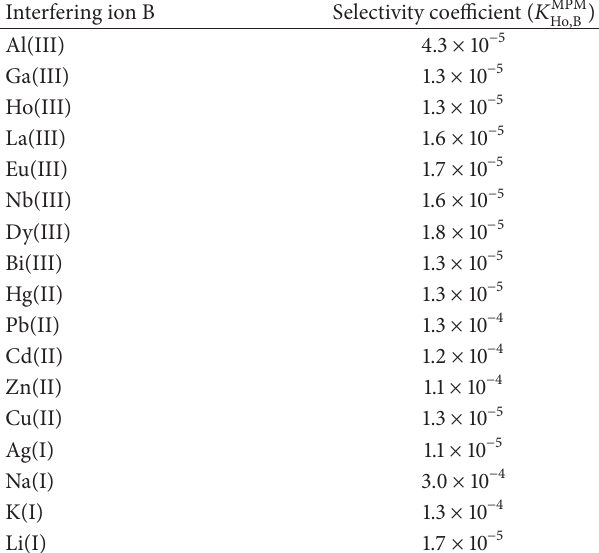
Table 3: Selectivity coefficients of various interfering ions (B). Interfering ion